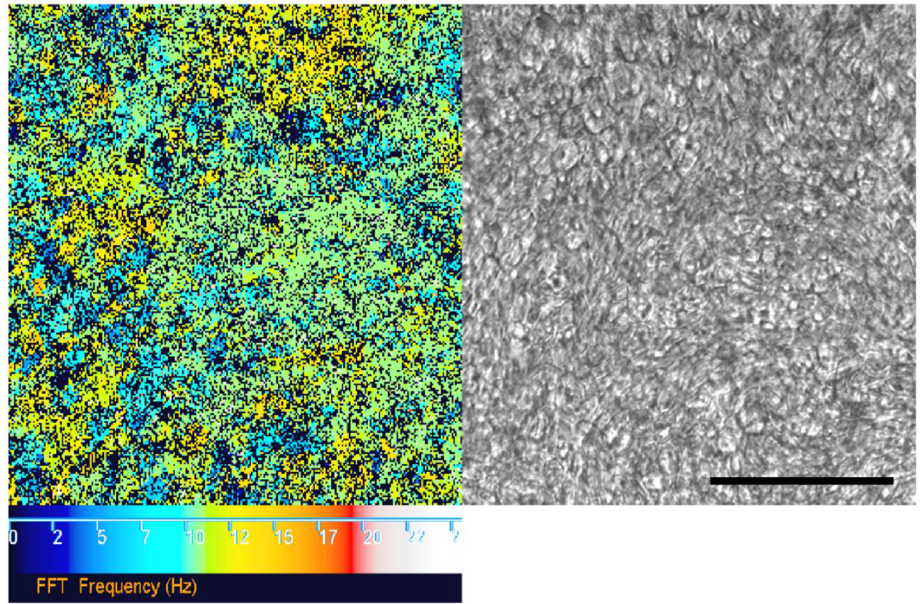
Figure 1. Fast Fourier transform (FFT) analysis of ciliary movement using high-speed video microscopy analysis (HSVA) data. FFT analysis (left) “colour map” corresponding to ciliary movement detected by HSVA (using a 20× objective lens) on the surface of an air–liquid interface (ALI) culture (right). The colour scale (left to right) depicts increasing ciliary beat frequency (CBF) from 0 (black) to 25 Hz (white). Black pixels also represent a CBF measurement outside of the detection threshold (below 2 Hz or above 50 Hz). Normal mean CBF at 37 °C is 11–20 Hz. Scale bar represents 100 µm.